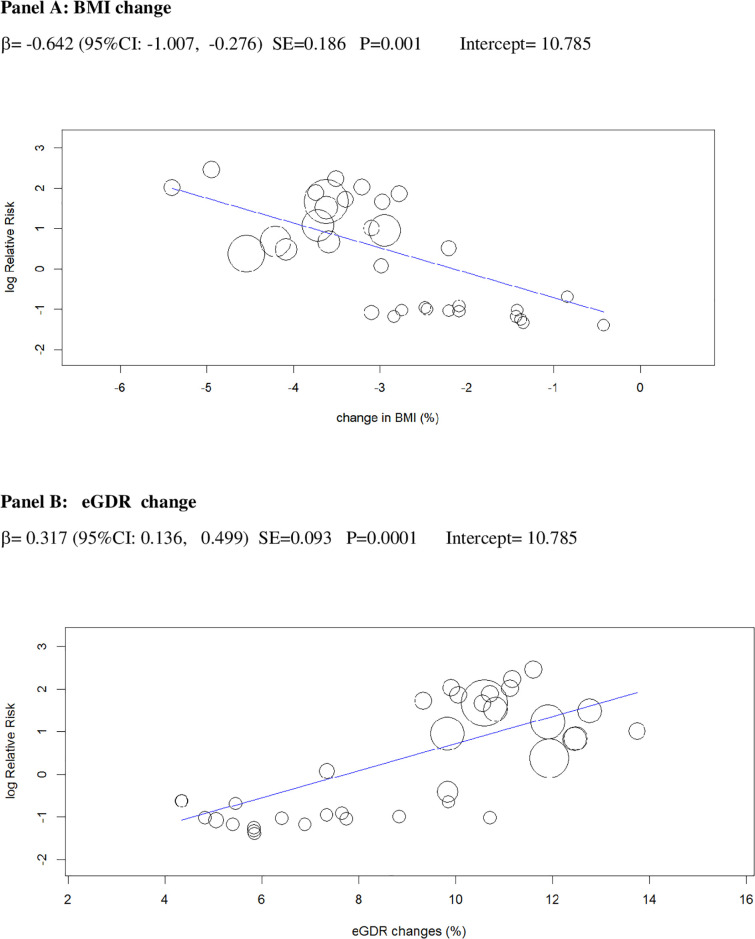
Univariable meta-regression plots for statistically significant moderators of the RR of DKA: Change in BMI and in eGDR.BMI, body mass index; DKA, diabetic ketoacidosis; eGDR, estimated glucose disposal rate; RR, risk ratio.